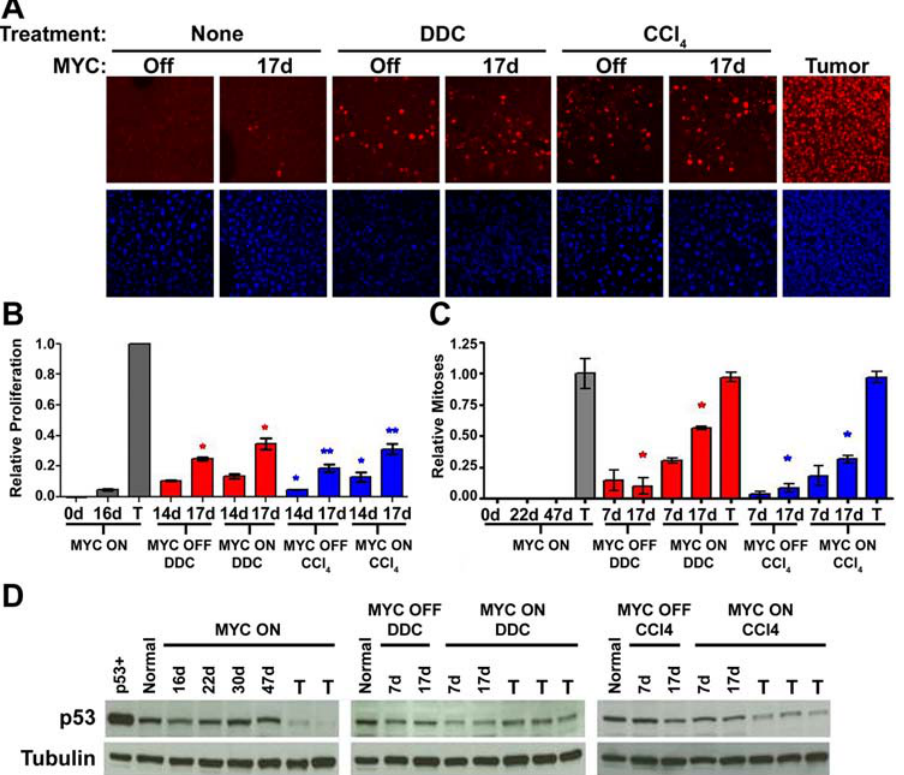
Figure 6. Hepatotoxins Facilitate MYC-Induced Proliferation Irrespective of p53 Status. (A) Immunofluorescence for Ki67 expression as a marker of liver cell proliferation is presented. (B) Bar graphs illustrating a ratio of Ki67 positive hepatocytes to total hepatocytes as a relative measure of hepatocyte proliferation are shown. (C) Bar graphs illustrate a ratio of phospho-Histone-H3 positive hepatocytes to total hepatocytes as a relative measure of hepatocyte mitotic division. Gray bar graphs represent normal adult livers in which MYC was either overexpressed (MYC ON/Adult), or kept inactive (MYC OFF/Adult). Red bar graphs represent DDC-treated livers in which MYC was either overexpressed (MYC ON/DDC), or kept inactive (MYC OFF/DDC). Blue bar graphs represent CCl 4 -treated livers in which MYC was either overexpressed (MYC ON/ CCl 4 ), or kept inactive (MYC OFF/ CCl 4 ). T represents a liver tumor. Results are based on an average of 4 samples per time-point. Statistical significance was measured using a Mann Whitney test: graph in (A) (* P , 0.05, ** P , 0.05), and graph in (B) (* P , 0.05). (D) Western blot analysis for p53 protein expression after different durations of MYC overexpression in: Normal, DDC-treated, and CCl 4 -treated livers. As a positive control, a lymphoma cell line that overexpressed a mutant p53 was used. Normal FVB/N adult liver was used as a negative